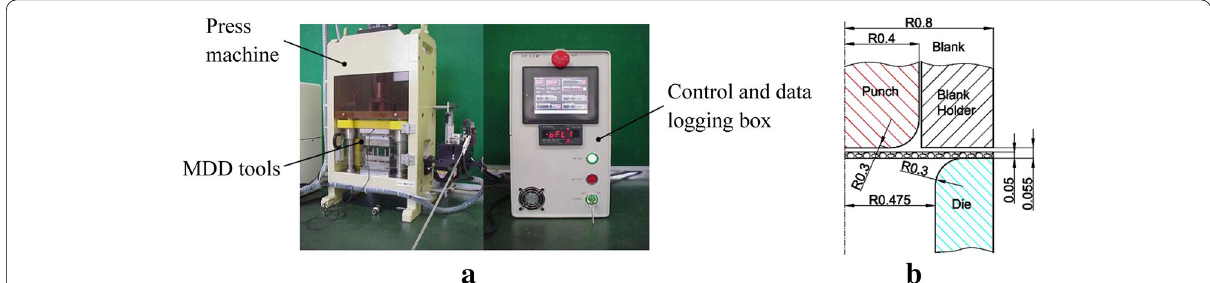
Figure 2 a Desk-top servo press machine DT-3AW, b key parameters of MDD tools (unit: